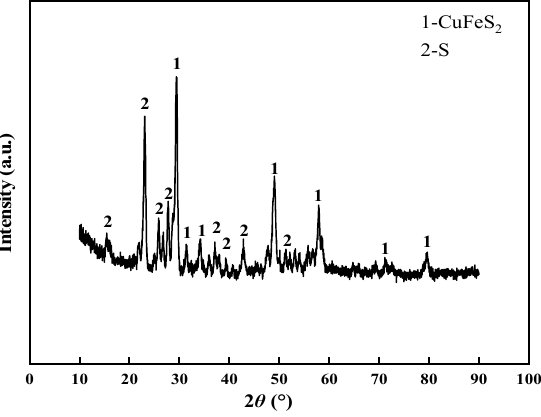
Figure 5. XRD pattern of leached residue.